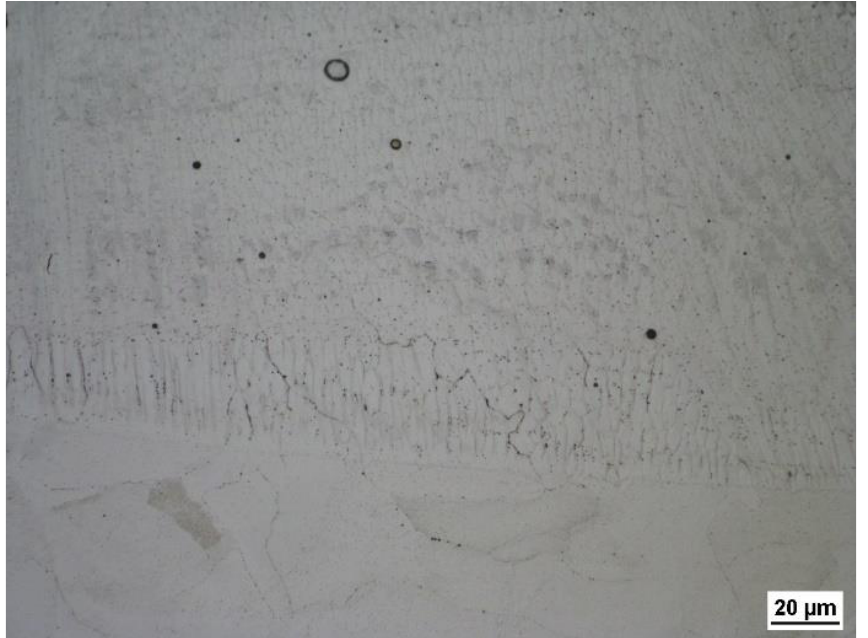
Figure 12. 1_T specimen microstructure showing the incomplete martensitic transformation.